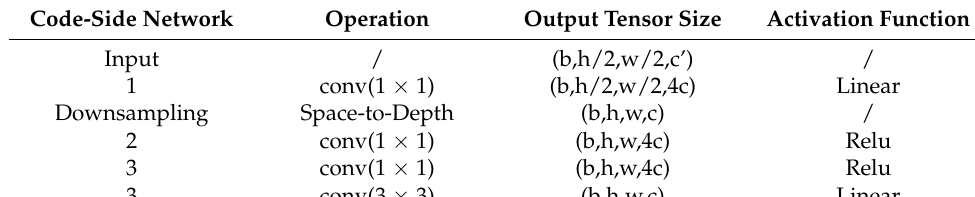
Table 2. Hyper synthesis transform.